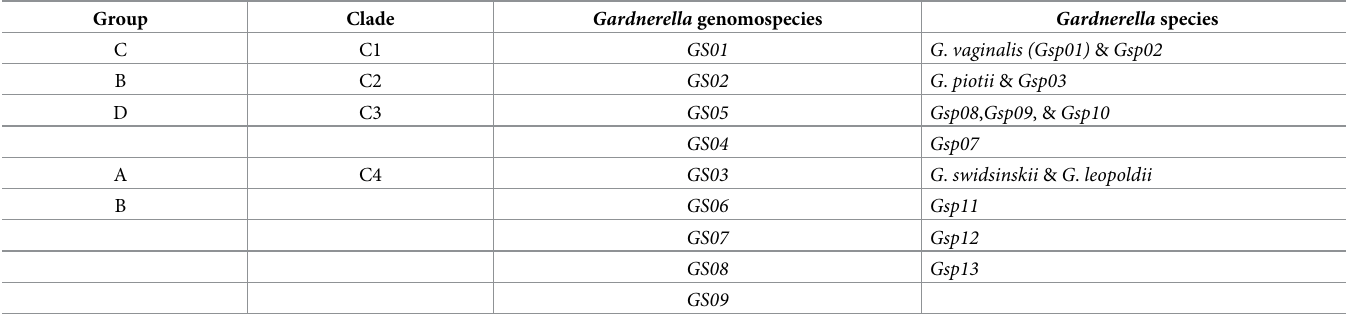
Table 1. Classification systems of Gardnerella